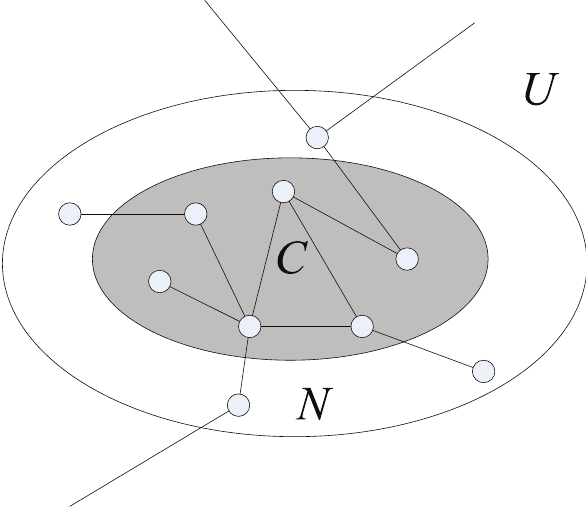
Figure 1. An illustration of the division of an abstract graph into the local community C , its neighborhood N , and the edges that connect N to the unknown vertices in U .